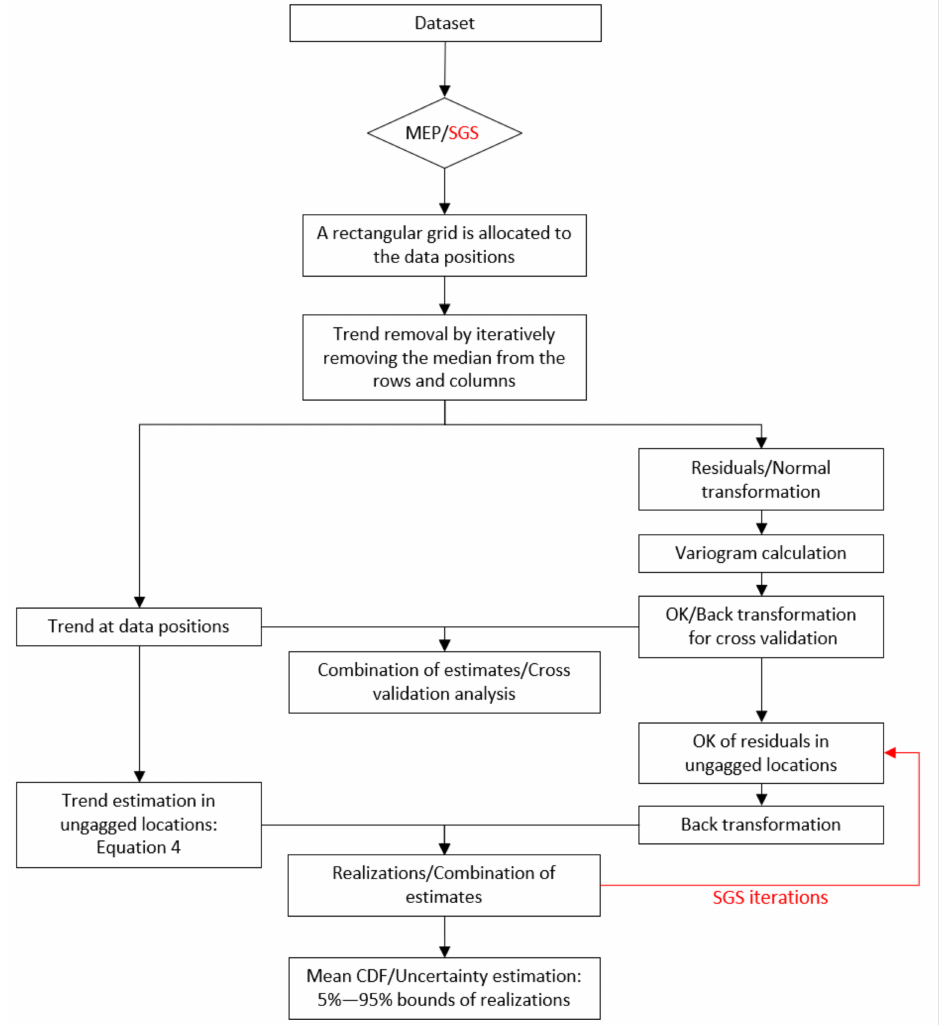
Figure 2. Methodology flowchart of the combined median polish (MEP) kriging and sequential Gaussian simulation (SGS) geostatistical approach (CDF stands for cumulative distribution